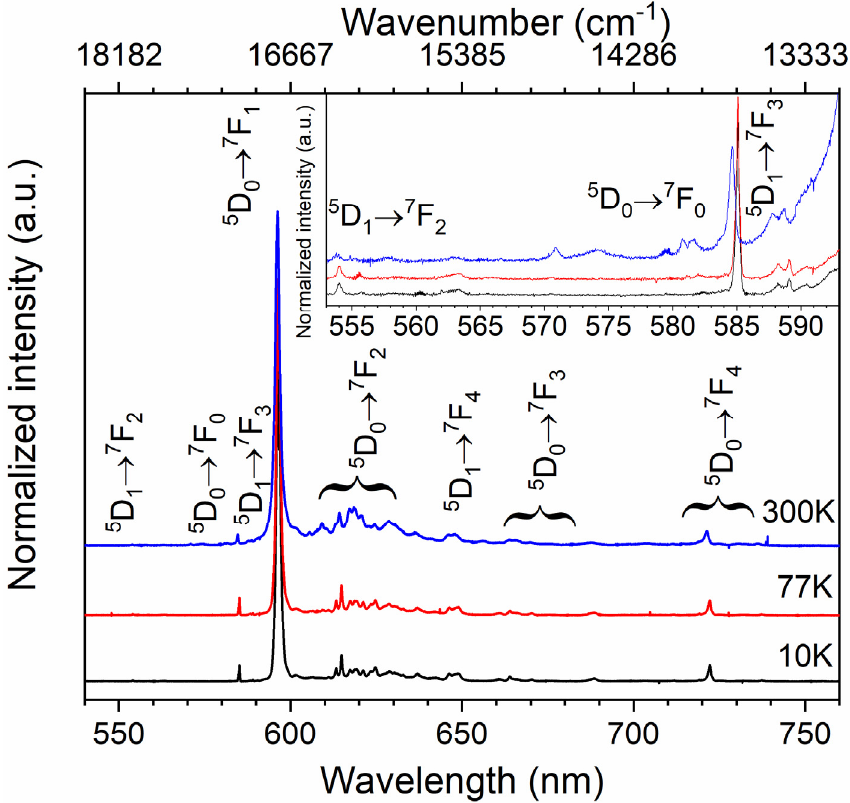
Figure 5. The 300 K (blue), 77 K (red) and 10 K (black) emission spectra of Ba 2 MgWO 6 : 5% Eu 3+ excited at 266 nm.